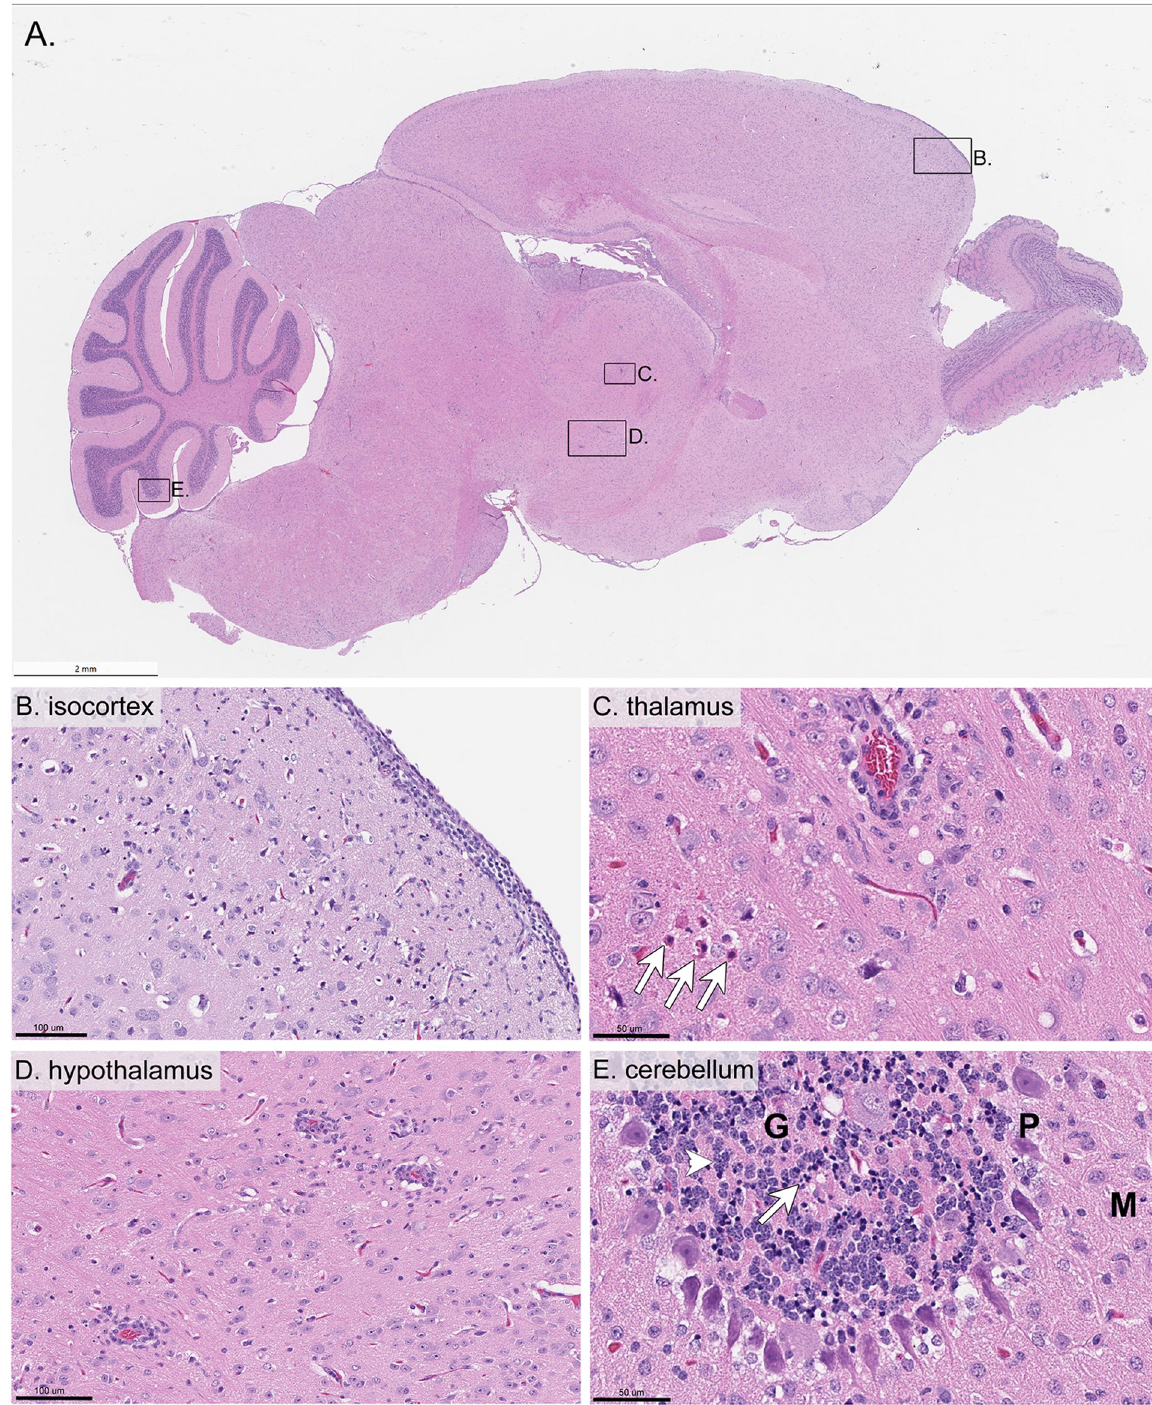
Fig 5. Hematoxylin and eosin-stained sections of brain from a mouse inoculated with 10 3 FFU DTV. This tissue was harvested from a moribund mouse at 7 dpi and H&E stained. A ) Whole brain sagittal cross-section. B ) Isocortex C ) Thalamus (arrows indicate eosinophilic degenerating neurons characterized by nuclear pyknosis) D ) Hypothalamus E ) Cerebellum (arrow points to basophilic and shrunken neurons, whereas the arrowhead points to adjacent more normal neurons). G = granule cell layer, P = Purkinje cell layer, M = molecular cell layer.